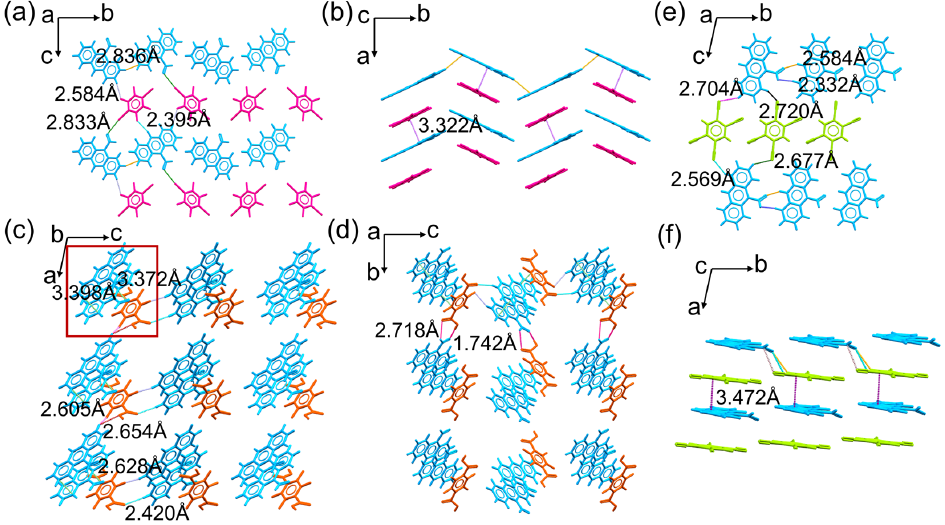
Figure 3. Molecular packing structures of ( a , b ) AA-DITFB, ( c , d ) AA-TFTPA, and ( e , f ) AA-TCNB. AA-TFTPA crystallizes in the space group P2 1/c of the monoclinic system. Two 9-AA molecules and one TFTPA molecule form an asymmetric unit through π – π interactions (3.398 Å and 3.372 Å) (Figure 3c, red box). The asymmetric units form a one-dimensional chain along the a-axis via the interaction of C-H···F (2.605 Å) and C-H···O (2.654 Å), and the adjacent chains form a 2D network along the c-axis under the action of C-H···F and C-H···O. Adjacent layers are connected via C=O···H (2.718 Å) and O–H···O (1.742 Å) hydro- gen bonds (Figure 3d) to build the supramolecular assembly of AA-TFTPA.